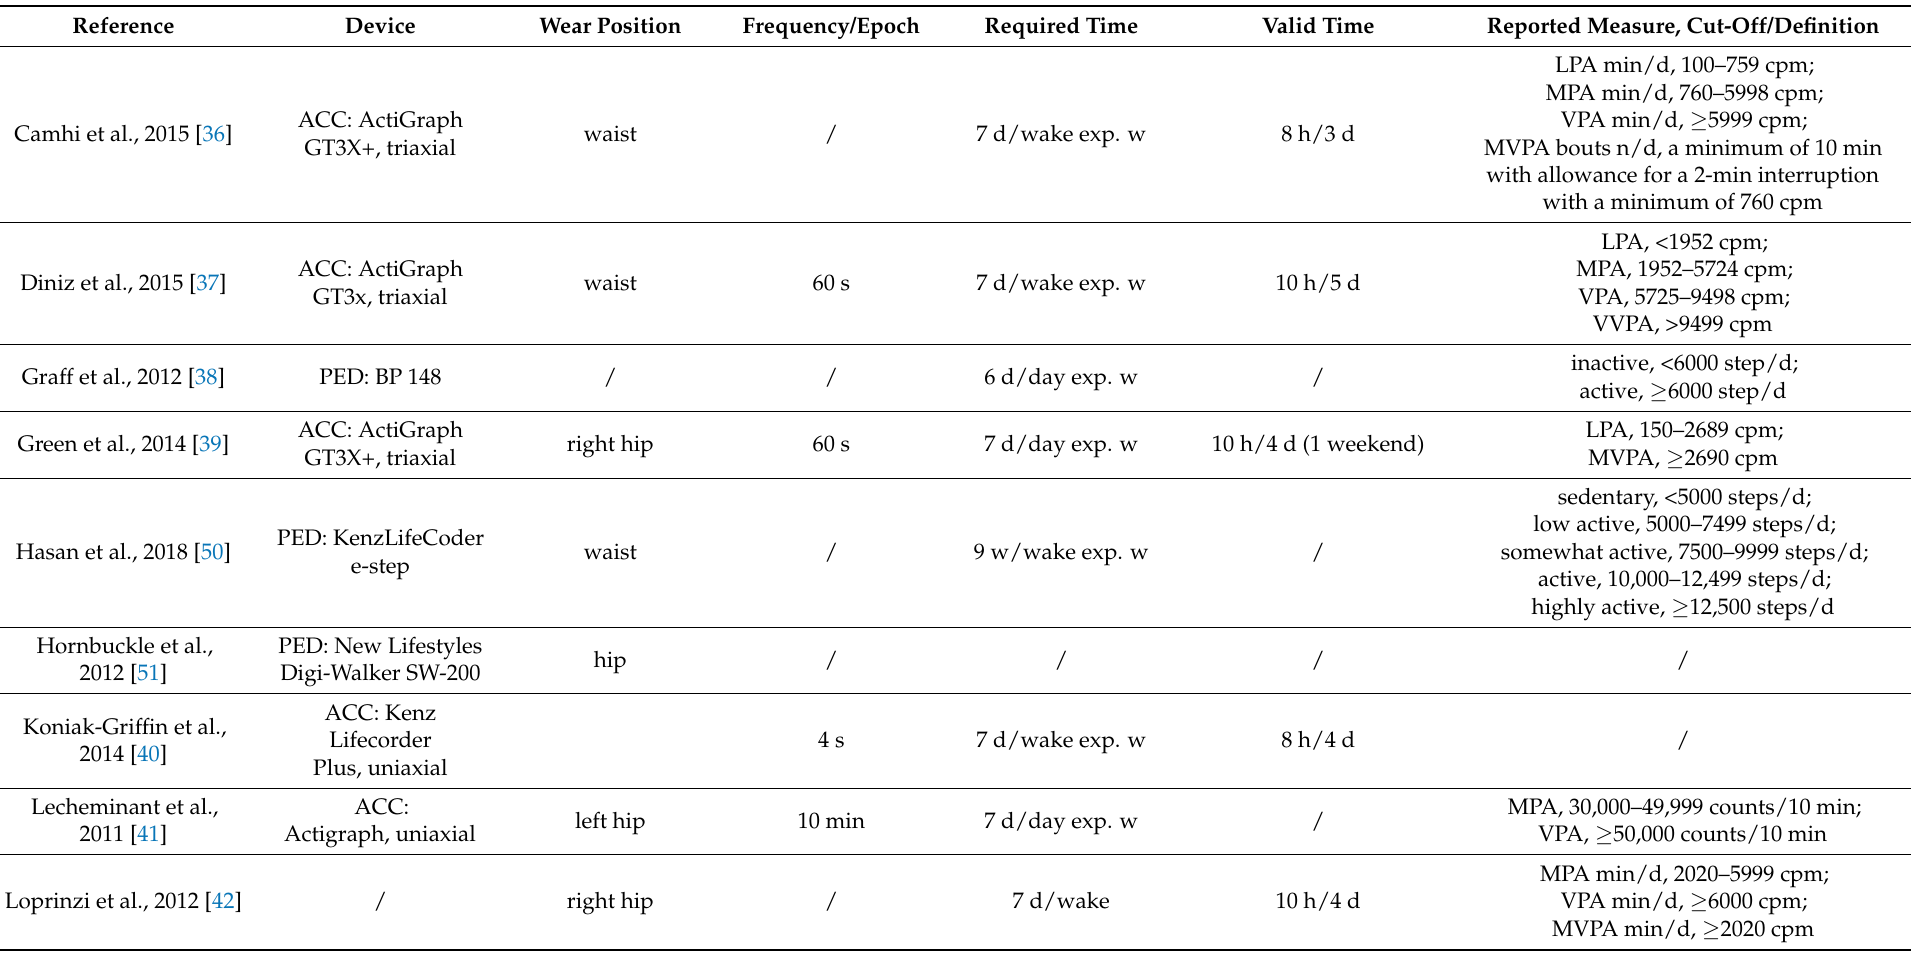
Table A2. Ascertainment and measurement characteristics of objectively measured